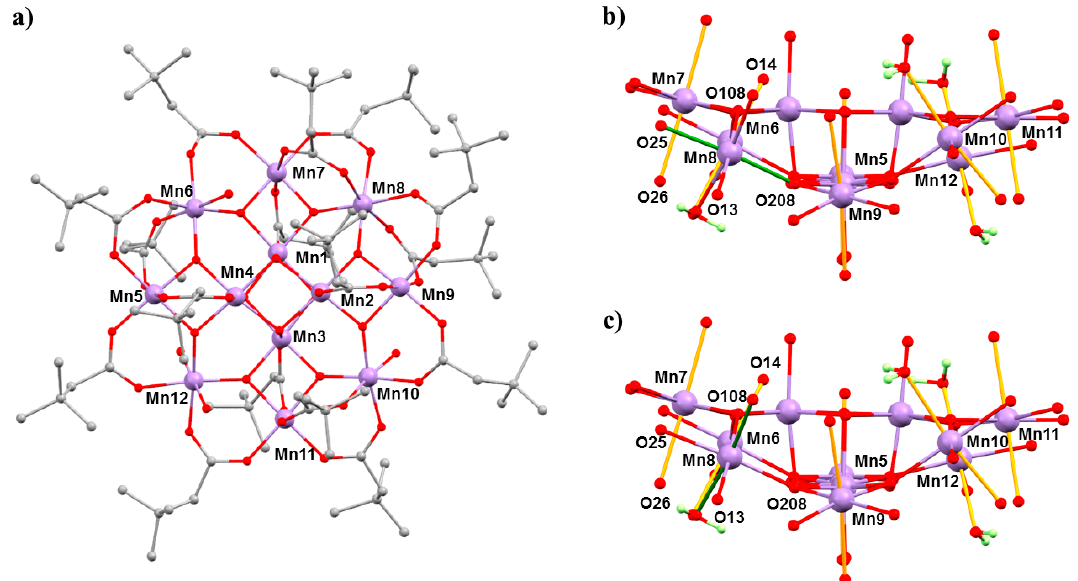
Figure 6. ( a ) The molecular structure of complex 4 . ( b ) The structure of the Mn–O core of 4 at ambient pressure and ( c ) at 2.5 GPa. The ‘vertical’ JT bonds are coloured orange, and the JT bonds on Mn8, which switches with applied pressure, are coloured green. Colour code: Mn = lilac, O = red, C = grey, H = pale green. H atoms (except on H 2 O ligands shown in ( b , c )) and solvent molecules are omitted for clarity.